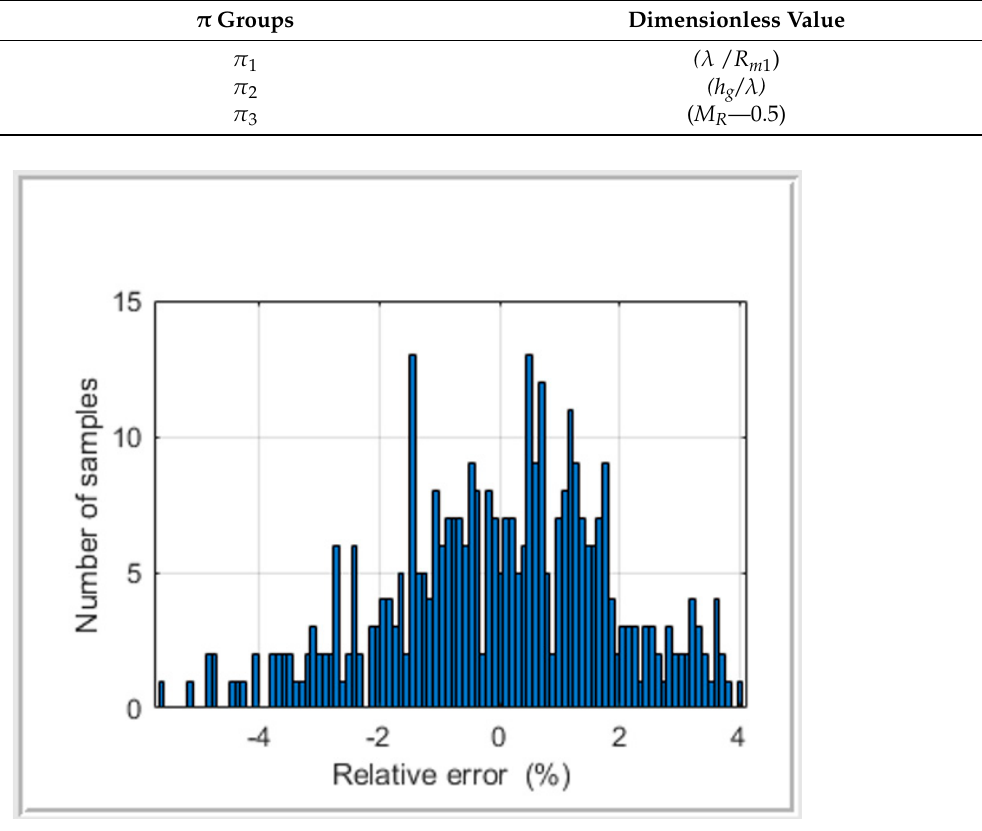
Figure 8. Error Histogram for P c N Actual vs. P c N Estimated over 368 data samples. The value for P C N Estimated was calculated